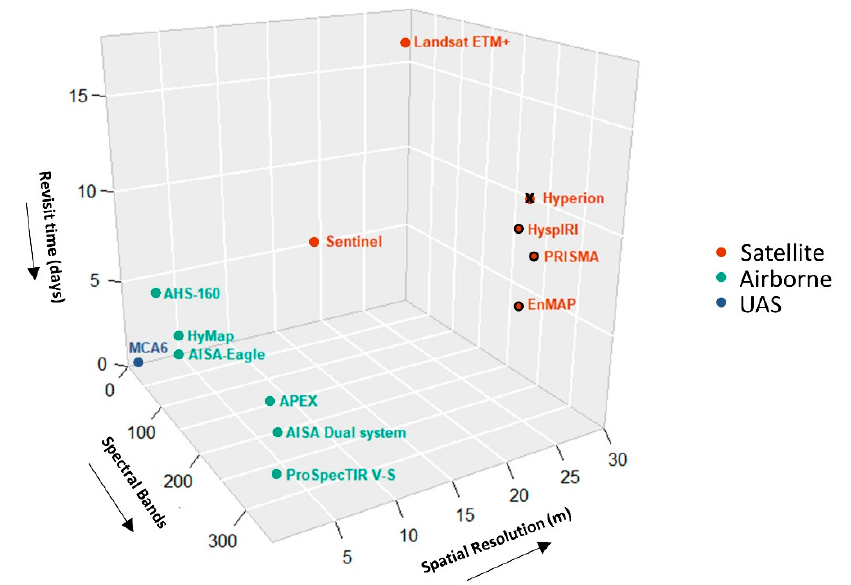
Figure 2. An overview of spatial spectral and temporal resolution of different RS systems that have been applied in SOC estimation. The black outlined symbols indicate the forthcoming remote sensing systems, while the x mark indicate that Hyperion is not in operational status.